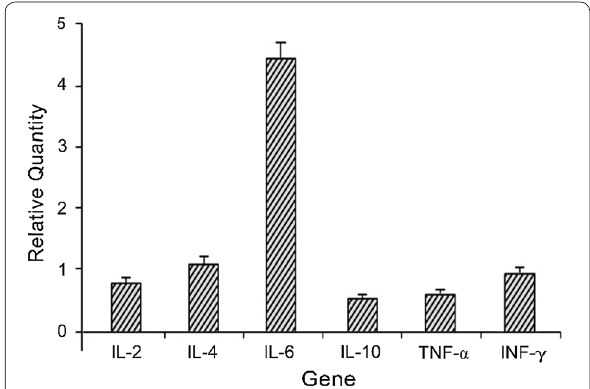
Fig. 9 Effects of MIPs on the expression of target genes (n